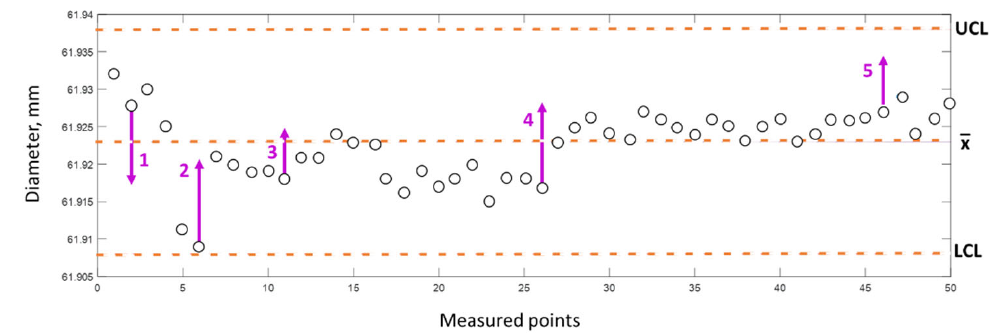
Figure 4. Diameter measurement value at point A on the workpiece for the first fifty workpieces (50 measured points) with process corrections marked.